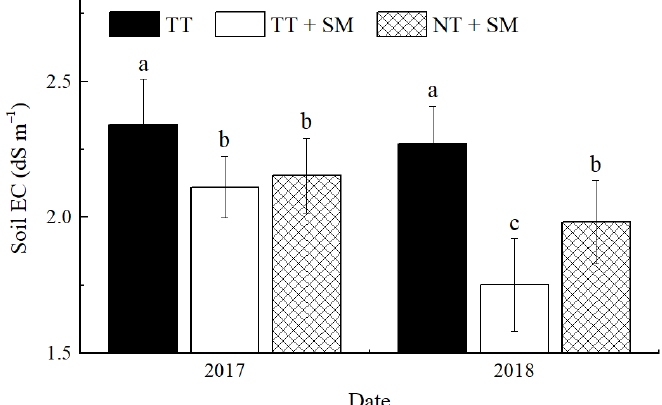
Figure 2. Mean soil electrical conductivity (EC) in the upper 30 cm profile for the TT, TT + SM, and NT + SM treatments. TT: traditional tillage for maize cultivation without straw return after maize harvest; TT + SM: traditional tillage with 100% straw mulching after harvest; NT + SM: no-till cultivation combined with 100% straw mulching. Data were measured at the end of fallow period, i.e., early June of 2017 and 2018 before maize sowing. Means in the same year followed by a different letter are significantly different ( p = 0.05).